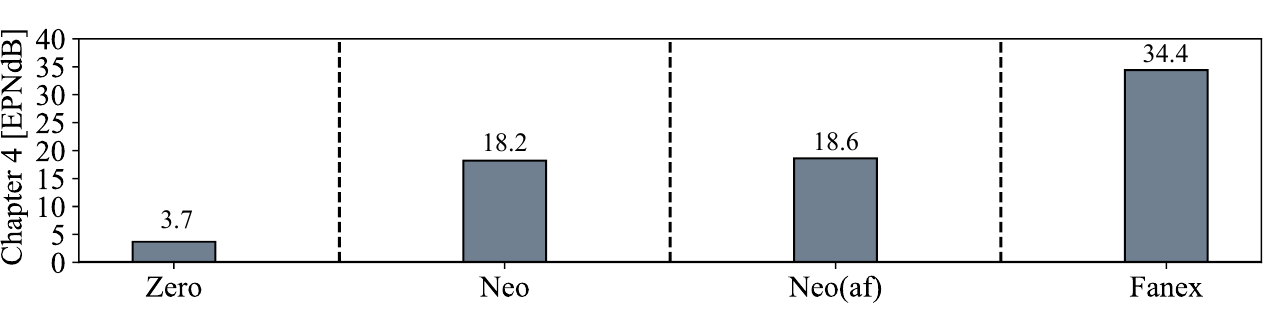
Figure 8. Margin to cumulative Limit of chapter 4 for studied aircraft designs ( zero , neo , neo ( af ), fanex